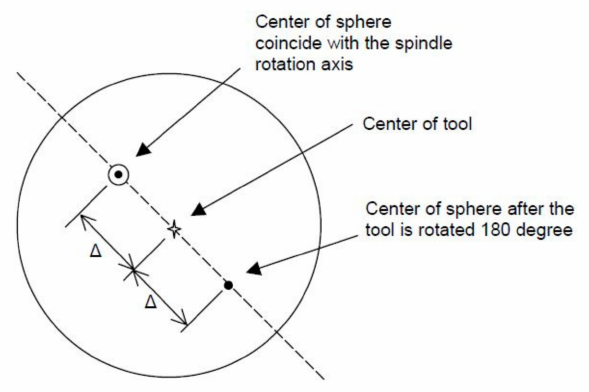
Figure 19. Schematic illustration of the effect of rotating the spindle by 180 degrees